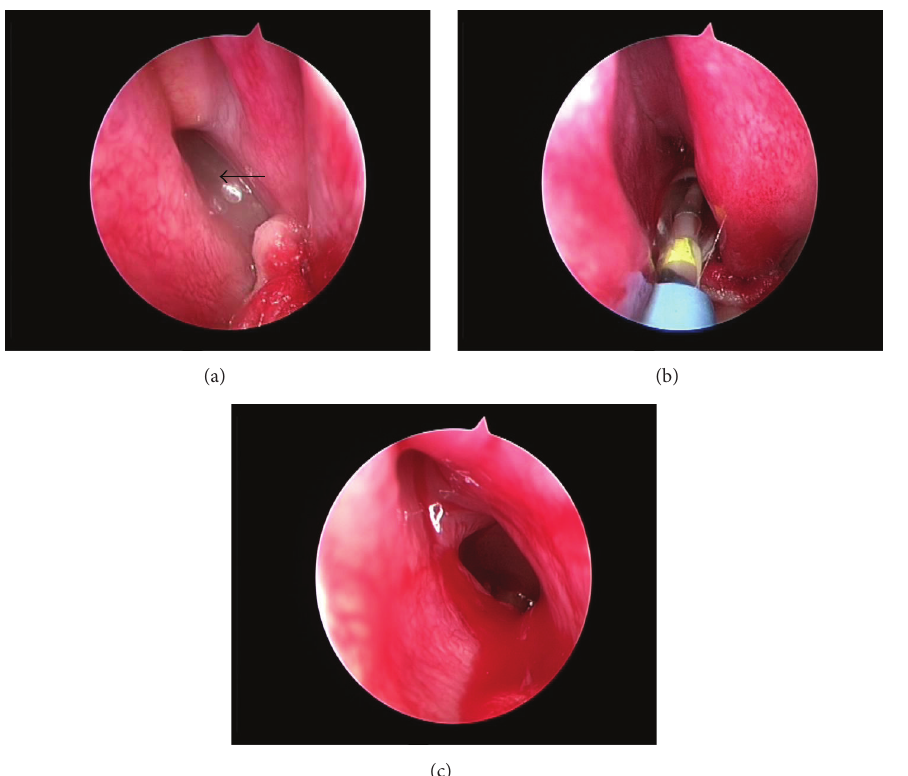
Figure 2: (a) Endoscopic visualisation of mucosal edema in the left sphenoethmoidal recess during operation ( black arrow ). (b) Balloon dilating sphenoid sinus ostium. (c) Larger sphenoid sinus ostium after dilating and mucosal edema in the